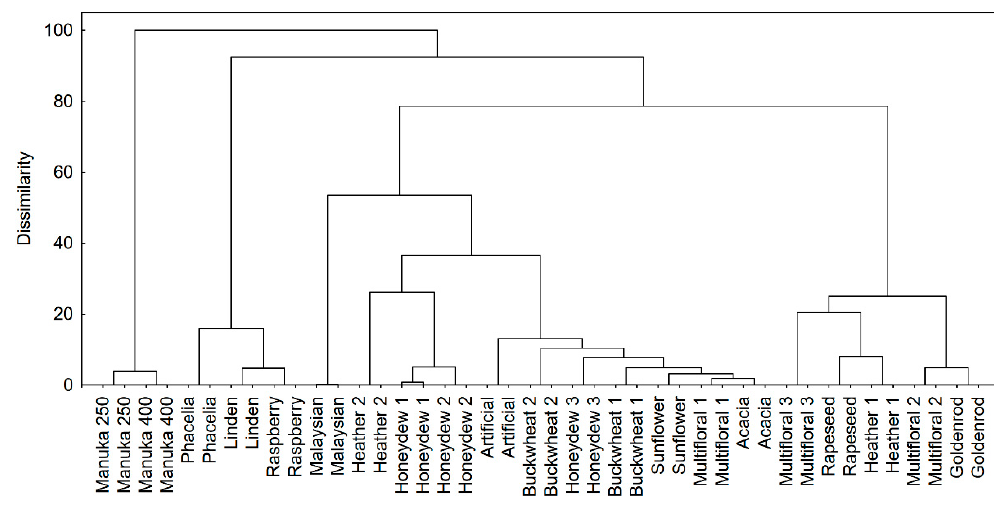
Figure 1. Cluster analysis results—the data set with 1252 compounds was included as a fingerprint of a sample; Ward’s method was used as an amalgamation rule and squared Euclidean distances were used as a distance measure.